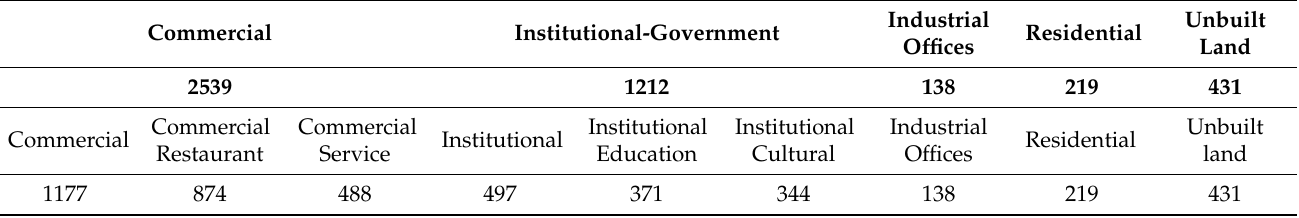
Table 2. Distribution of classes in the